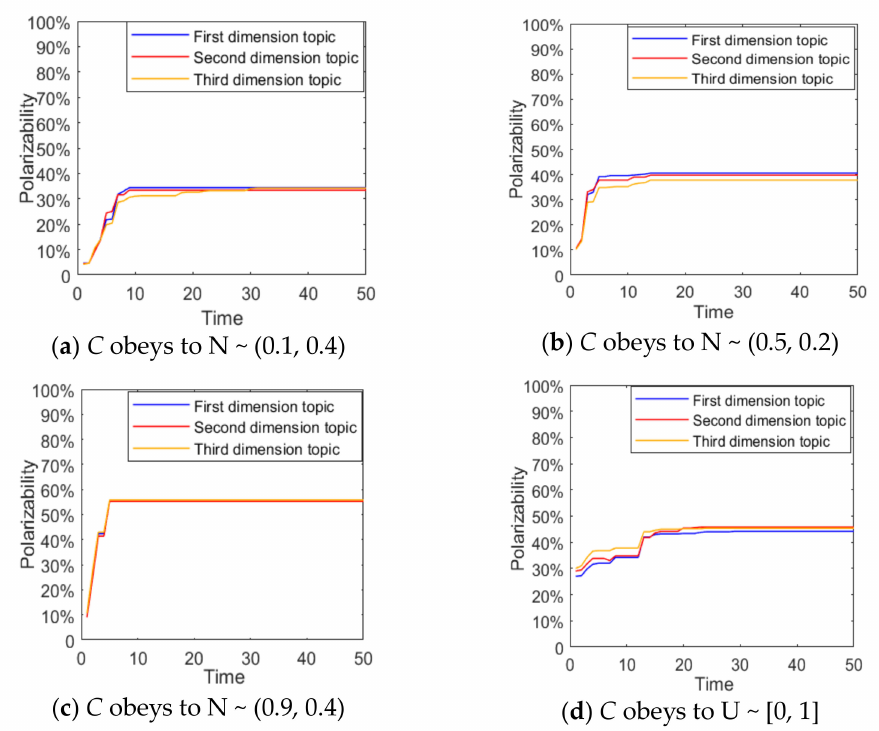
Figure 9. Polarizability curves of group attitude under individual view confidence with different